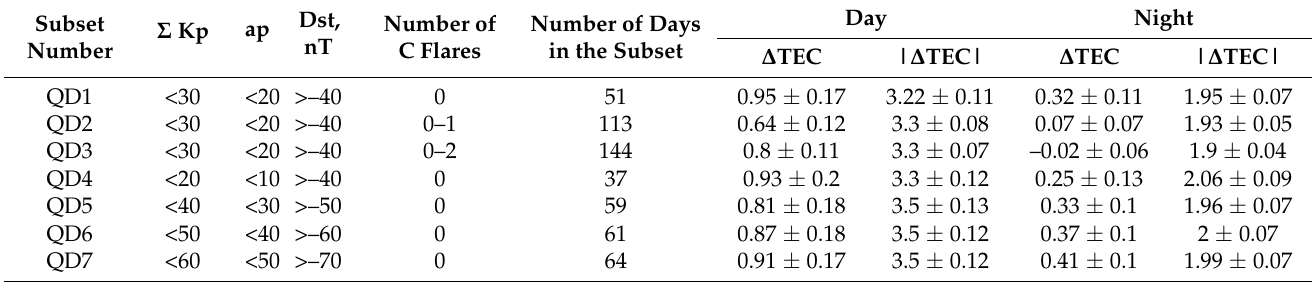
Table 9. Parameters of the subsets of QDs and the mean ∆ TEC (in TECu) values. Data are for the PCA-MRM model with L = 31 days and averaging the model with lag = 1 day and lag = 2